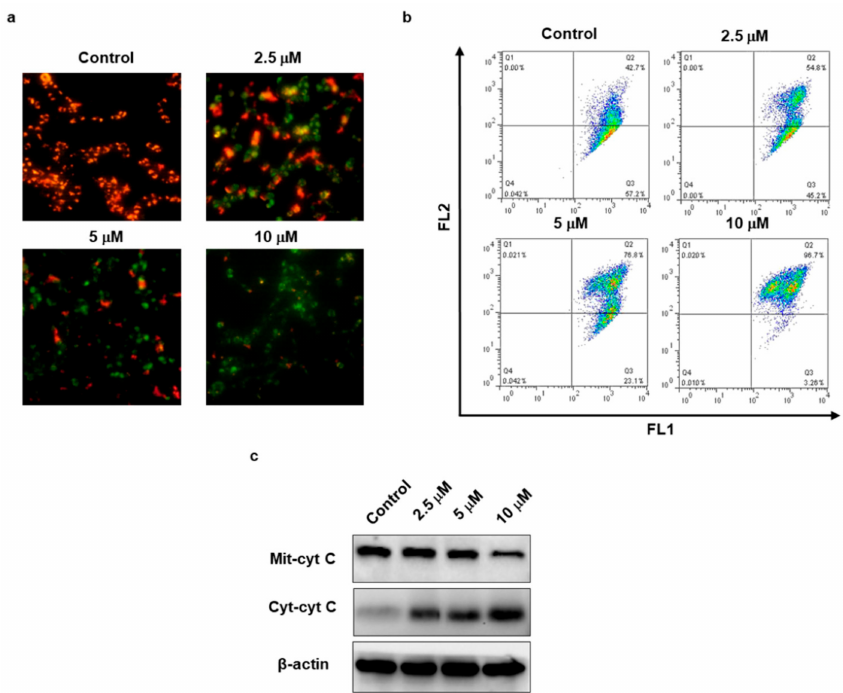
Figure 5. TSC-3C disruptsthemitochondrialmembranepotentialofMDA-MB-231cells. ( a )Mitochondrial membrane potential of MDA-MB-231 cells treated with various concentrations of TSC-3C and observed under fluorescence microscopy (200 × ). ( b ) MDA-MB-231 cells were treated with various concentrations of TSC-3C for 48 h. The cells were stained with JC-1 and analyzed by FACS. ( c ) MDA-MB-231 cells were cultured with TSC-3C for 48 h. Mitochondrial and cytoplasmic proteins were extracted. Western blotting was used to detect the level of cytochrome C. β -Actin was used to normalize the protein